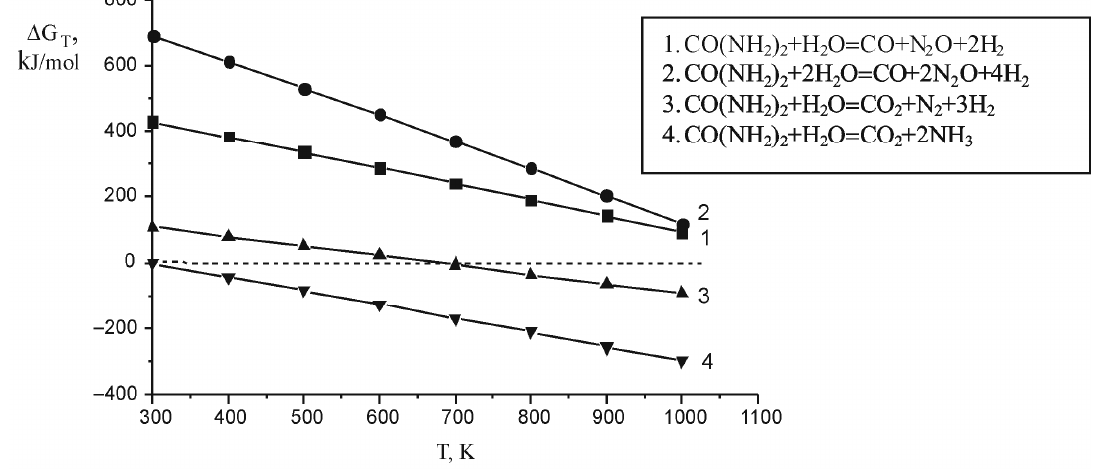
Fig. 6. The Gibbs’ energy value change dependency on temperature during reaction between carbamide and water vapour according to the equations presented in the